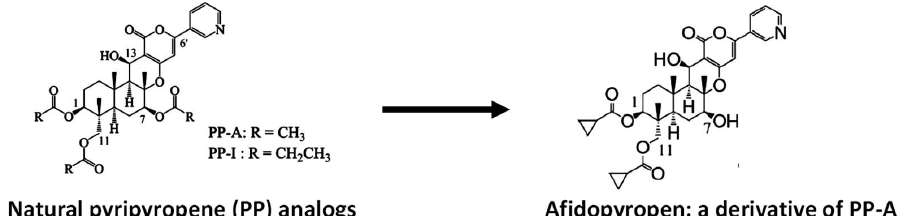
Figure 2. A derivative of natural pyripyropene shows superior aphicidal activity. Of >40 deriva- tives tested, the derivative with cyclopropanecarbonyloxy groups at the C-1 and C-11 positions and a hydroxyl group at the C-7 position showed the highest insecticidal activity against aphids